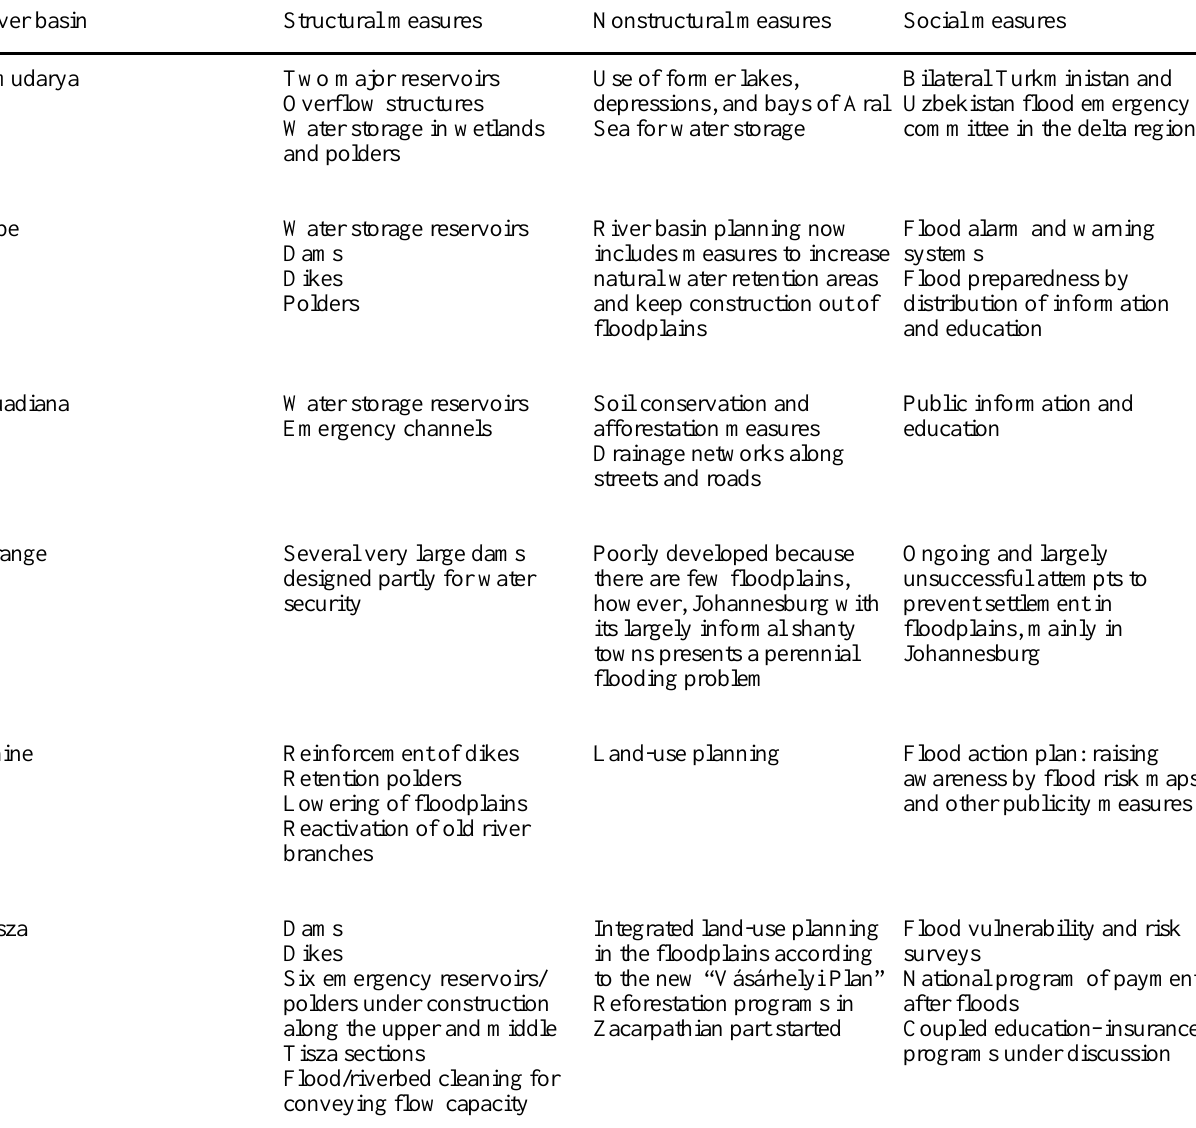
Table 6. Existing measures for coping with floods and droughts in six of the seven basins studied. The Nile, which runs through 10 countries, was not included because of insufficient data. Table 6A. Flood control